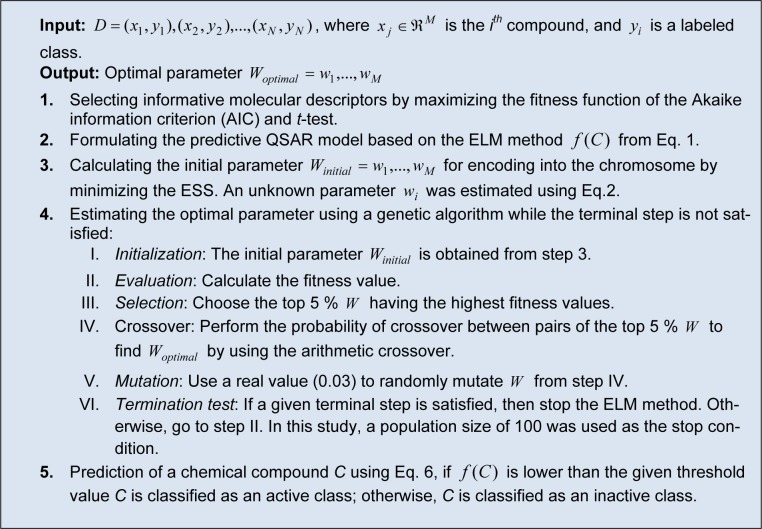
Pseudocode of ELM